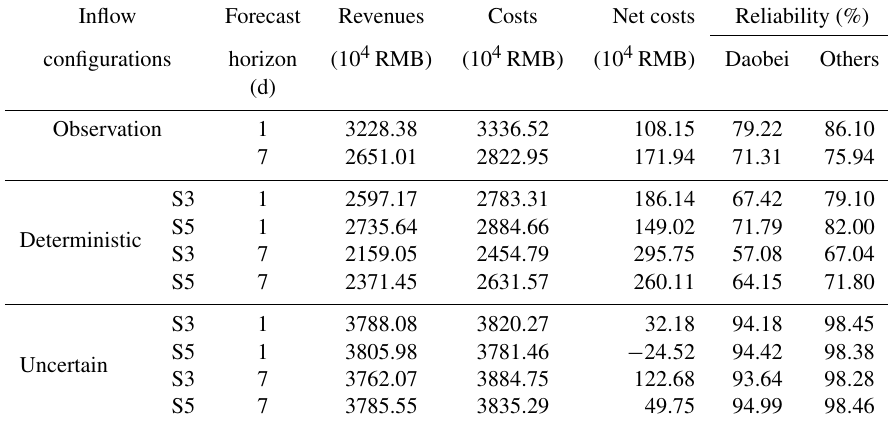
Table 7. Annual system performance using observed inflow